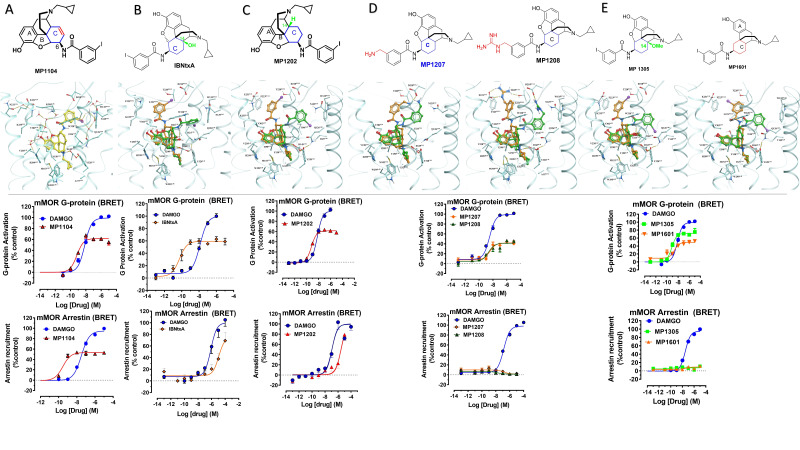
Characterization of ligands (MP1104, IBNtxA, MP1202, MP1207, MP1208, MP1305, and MP1601) at mouse mu opioid receptor (mMOR) using BRET assays-chemical structure, docking in MOR, G protein activity, and arrestin recruitment.(A) MP1104 targets the TM2-TM3 region and is arrestin-biased at mMOR: The preferred docking pose of MP1104 (boat form, yellow stick) at an active state of MOR is shown. Ring C of MP1104 in boat form forces the iodophenyl moiety to reside in a region between TM2-TM3. MP1104 (red) is a partial agonist in mMOR measuring G protein activation (N = 4) and arrestin recruitment (N = 4) compared to DAMGO (blue) in BRET assays. (B) IBNtxA targets the TM5-ECL2 region while showing reduced arrestin potency at mMOR compared to DAMGO: The docking poses of IBNtxA (chair form, orange stick) at an active state of MOR is shown. The saturated ringC in IBNtxA leads to interaction of the ligand in the ECL2 and TM5 region, which leads to a preference of chair form in our docking studies. At mMOR, it is a partial agonist for G protein signaling (N = 4) compared to DAMGO (blue) while showing reduced arrestin potency compared to DAMGO (N = 4) in BRET assays. (C) MP1202 targets the TM5-ECL2 region and shows reduced arrestin potency at mMOR compared to DAMGO. The preferred docking pose of MP1202 (chair form, orange stick) at an active state of MOR. The saturated ringC in MP1202 leads to interaction of the ligand in the ECL2 and TM5 region. MP1202 (red) is a partial agonist for G-signaling (N = 5) in mMOR and reduced arrestin potency (N = 5) compared to DAMGO (blue) in BRET assays. (D) MP1207 and MP1208 target the TM5-ECL2 region and show no arrestin recruitment at mMOR: Docking results showed that m-aminomethyl (MP1207) or m-guanidinomethyl (MP1208) moieties (replacing an iodo group in MP1202) forced these compounds in chair form preferred confirmation at MOR (chair form in orange stick and boat form in green stick). MP1207 (orange) and MP1208 (green) are partial agonists at mMOR in BRET assays (N = 3) compared to DAMGO (blue). At MOR, chair forms of MP1207 and MP1208 introduce additional interactions between m-amino or m-guanidino group and D218ECL2 and T220ECL2. No arrestin recruitment was observed for both agonists (N = 3). (E) MP1305 and MP1601 target the TM5-ECL2 region and show no arrestin recruitment at mMOR. Chair and boat forms of MP1305 and MP1601 at an active state MOR (in cyan) are shown. Docking modes of MP1305 and MP1601 are analogous and they both maintain chair confirmation at MOR. In BRET assays using mMOR, MP1305 (green) and MP1601 (red) are partial agonists for G-signaling (N = 3) compared to DAMGO (blue) with no measurable arrestin recruitment (N = 3). In summary, targeting TM5-ECL2 and ring C taking chair form leads to reduced arrestin signaling at MOR in both rodents as well as human receptors with analogs. See Appendix 1—table 8 for values, Appendix 1—figure 4 and Appendix 1—table 11 for bias calculations.